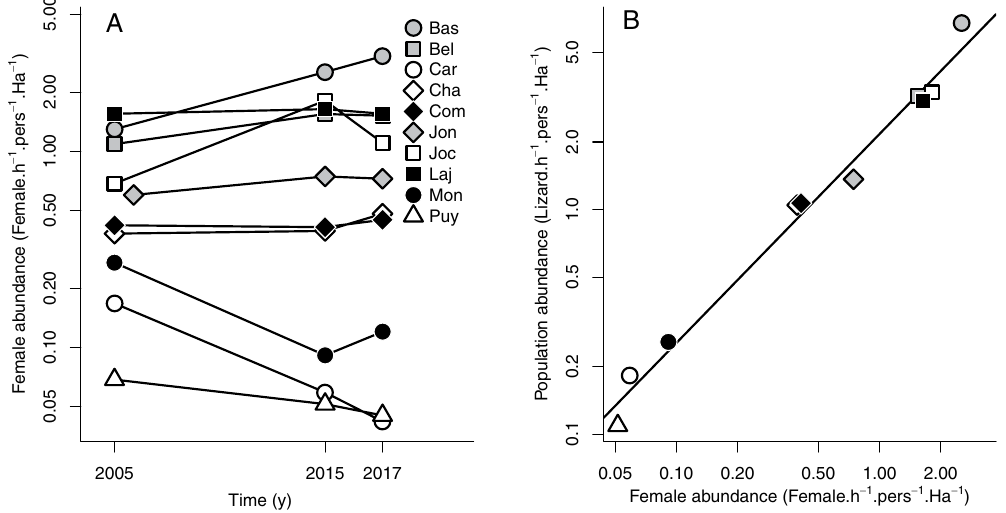
Figure 1. Changes in the abundance of the common lizard from monitored populations (Barnesac: Bas, Bel Air: Bel, M t Caroux: Car, Chalet du M t Lozère: Cha, Col du Cheval Mort: Com, Gerbier de Jonc: Jon, Gerbier de Jonc II: Joc, Lajo: Laj, Montselgues: Mon, and Puy Mary: Puy) over 12 years. We used ( A ) the change in adult female abundance to estimate the change in population abundance including adults females and males and yearlings because ( B ) both are highly correlated in 2015 ( r 2 = 0.96, P <